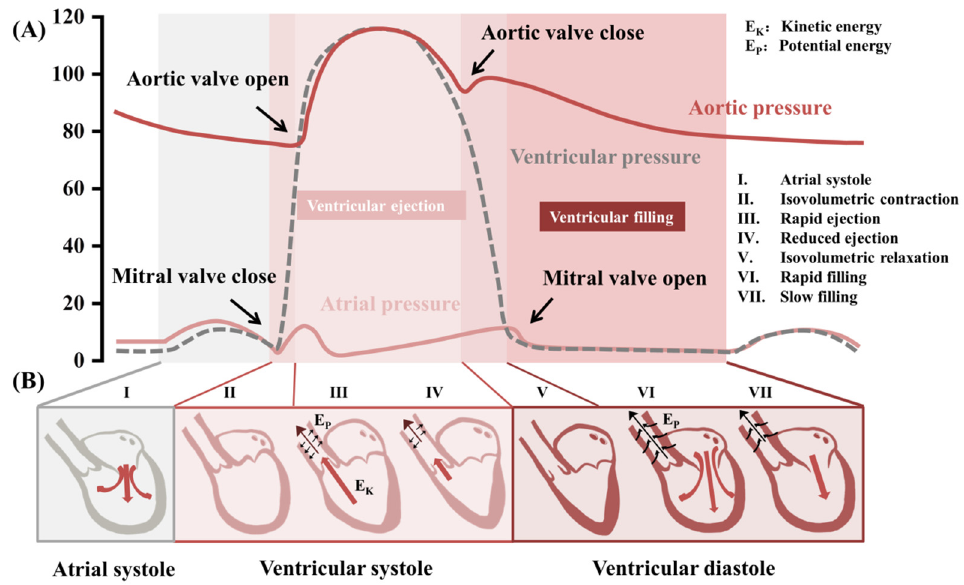
Figure 2. ( A ) The waveforms of aortic blood pressure versus ventricular and atrial blood pressure. ( B ) Cardiac cycle: the energy released by ventricular systole can be divided into two main compo- nents: the kinetic energy (E K ) that drives the rapid flow of blood and the potential energy (E P ) stored in the vascular wall.